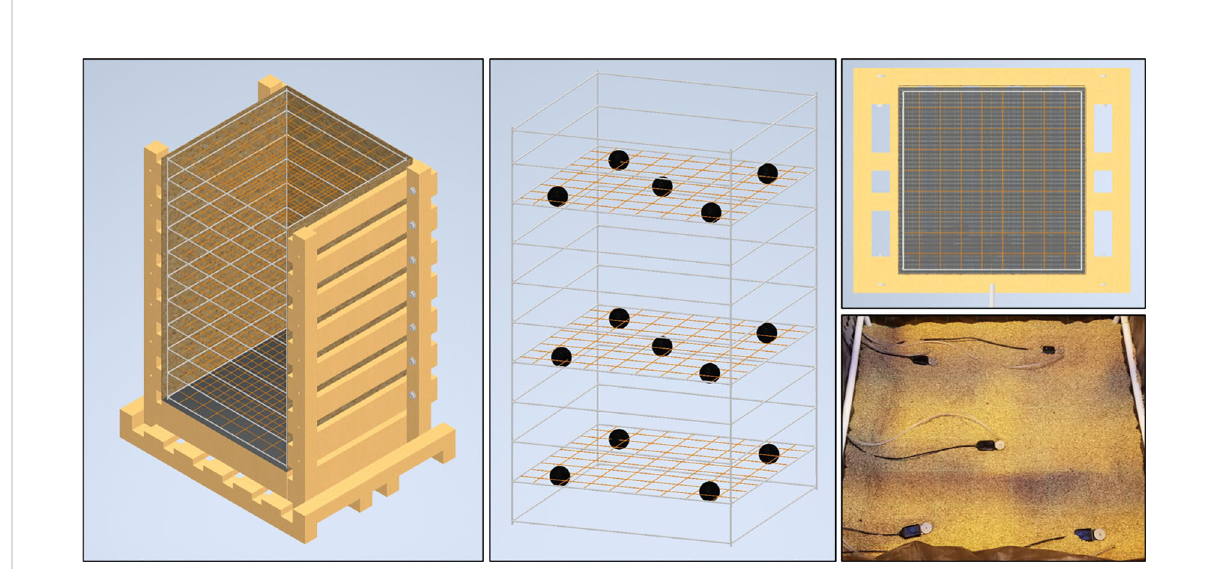
FIGURE 2 Interior sensor layout of the mesocosm. The interior PVC and fi shing line scaffold create a coordinate system that can be used for sensor placement and data interpolation. Various environmental sensors (black spheres) were placed in a grid formation at 3 elevations throughout the mesocosm growth pro fi le, 1.25 ft, 2.5 ft, and 4.25 ft deep. At the two upper elevations 5 sensors are laid out in a cross pattern while on the lowest level there are 4 with the center sensor absent. The lower right panel shows a photograph of both TEROS21 matric potential/ temperature sensors as well as air intake tubes for a Picarro gas